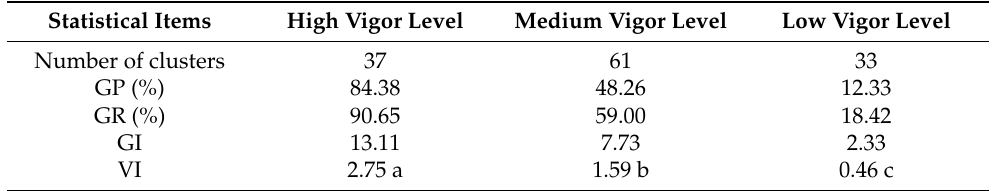
Table 2. Number of genotype clusters and their mean values of the vigor indexes of 131 soybean strains included in the regional test in Huanghuaihai, China, in 2019. Statistical Items